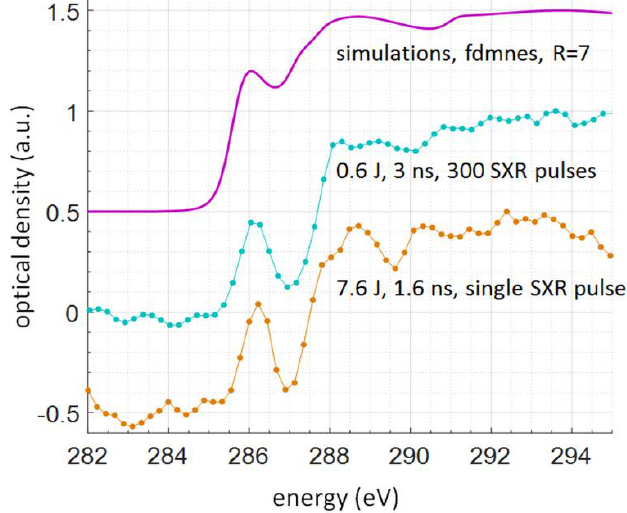
Figure 6. The relative values of the optical density of the L-ascorbic acid sample obtained near the carbon K-α absorption edge for multiple SXR pulses (compact system reported in [22]) and a single SXR pulse, compared to fdmnes numerical simulations (top plot).